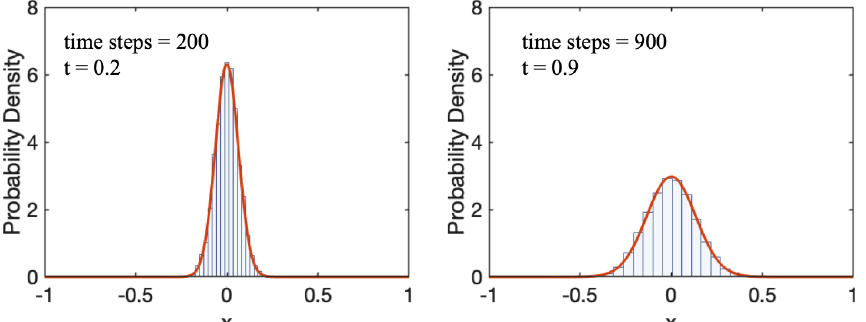
Figure 5. Probability density function (PDF) for position of particles diffusing via one-dimensional Brownian motion. Histograms correspond to LE data and solid lines corresponds to FP solutions. In this figure, D = 10 − 2 µ m 2